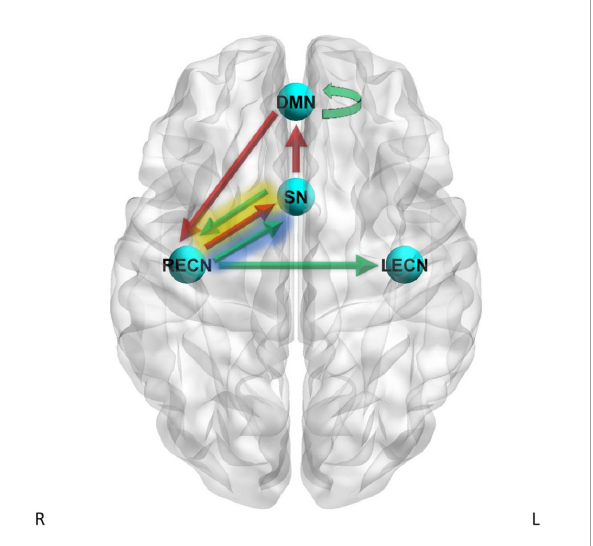
FIGURE2 Dynamic causal modeling (DCM) PEB results – delay discounting. Green arrows = positive relationship between delay discounting log 10 (k) scores and effective connectivity, red arrows = negative relationship between delay discounting log 10 (k) scores and effective connectivity. Yellow shading = simple main effects in CD only, blue shading = simple main effects in HC